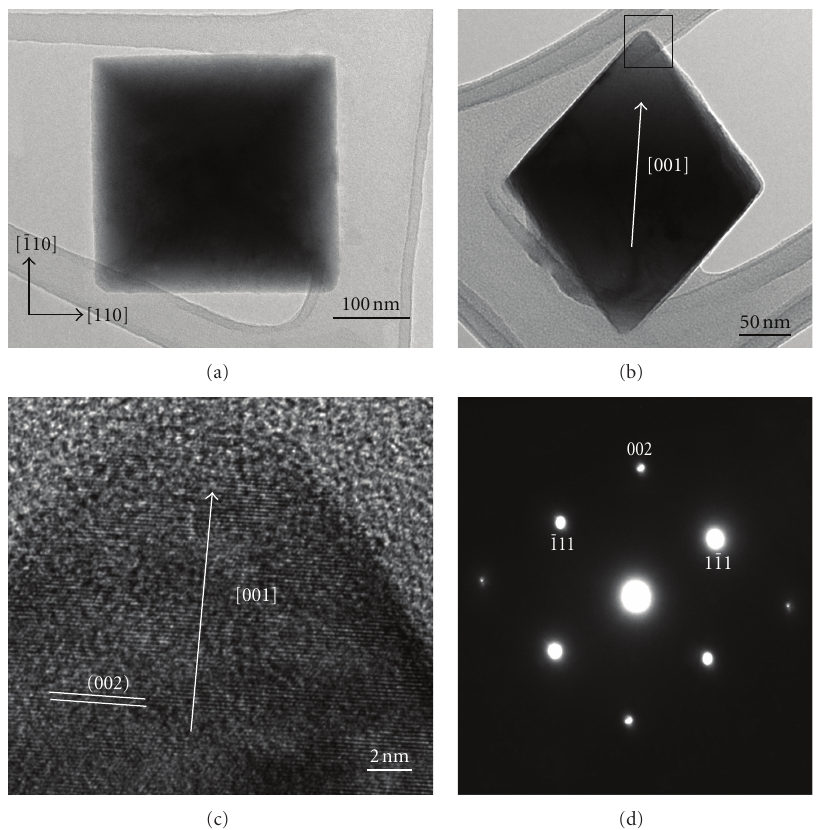
Figure 2: TEM images of individual Cu 2 O octahedron viewed from the top (a) and the side (b); (c) typical HRTEM image of the region enclosed by a square in (b); (d) corresponding SAED